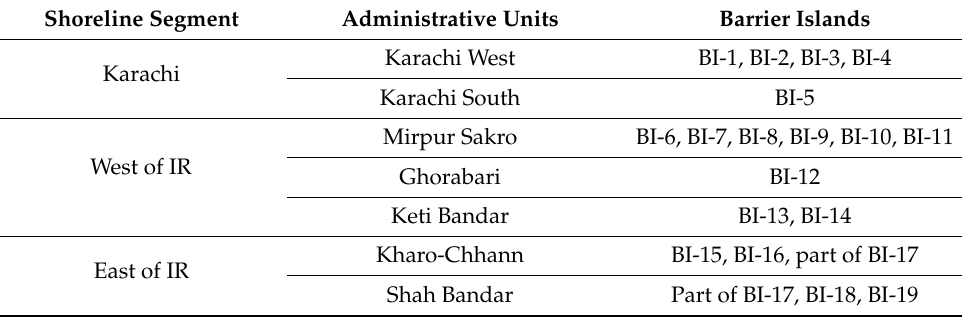
Table 1. Details of barrier islands (BIs) along Sindh coast (Note: IR = Indus